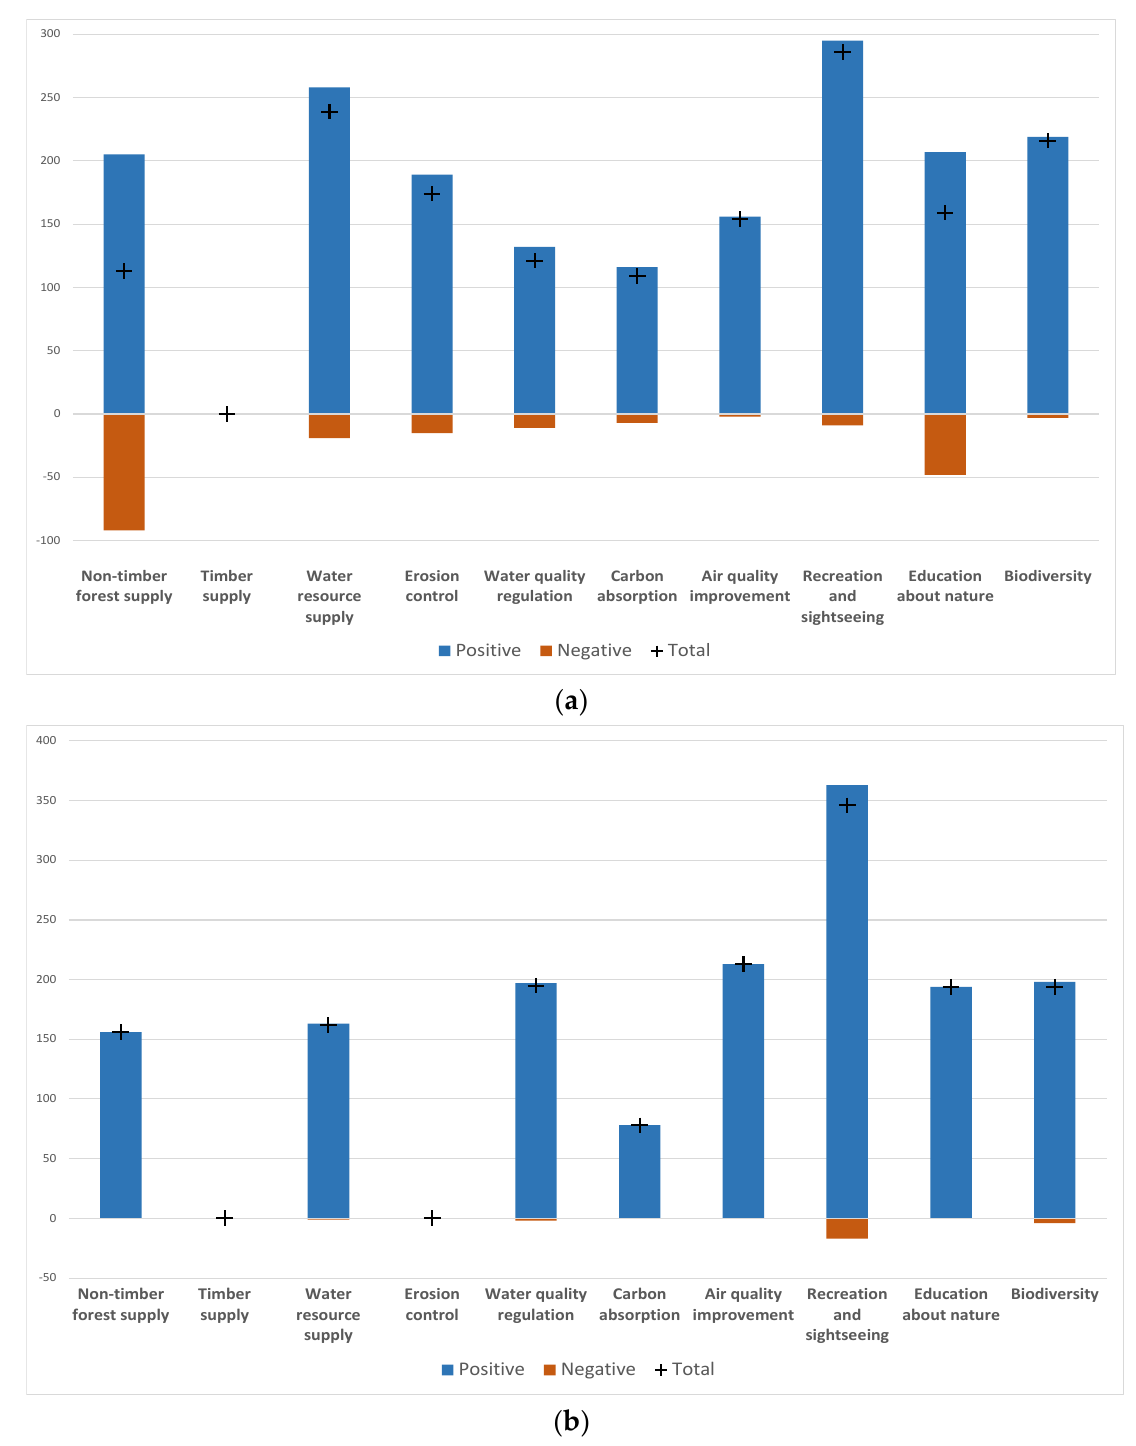
Figure 8. Results of the sentiment analysis of ( a ) Gariwangsan and ( b ) Yeoninsan. Due to the nature of the blogs and social media, the number of articles on the demand for recreation tourism is the highest. Hence, it was ranked at the top, and the demand for air quality improvement and water quality control was high, because hikers and campers frequently mentioned the air quality. In the case of water quality control, it was ranked third due to the frequent mention of garbage collection and its management, cleaning, and public toilet maintenance in and around the valley of Gariwangsan. In the case of recreational and sightseeing demands, these sentiments were ranked the highest in both